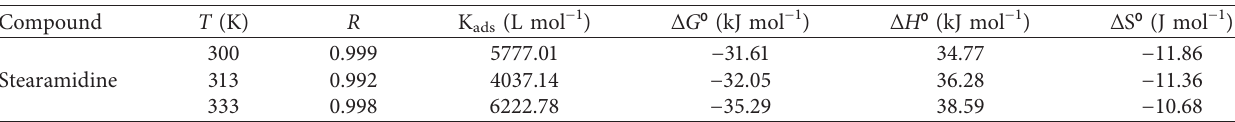
Figure 6: Langmuir-type adsorption isotherms of stearamidine in 1 wt.% NaCl solution at 300–333K. Table 2: Calculated thermodynamic parameters of the interaction between stearamidine and copper surface in 3.0 wt.% NaCl solution at